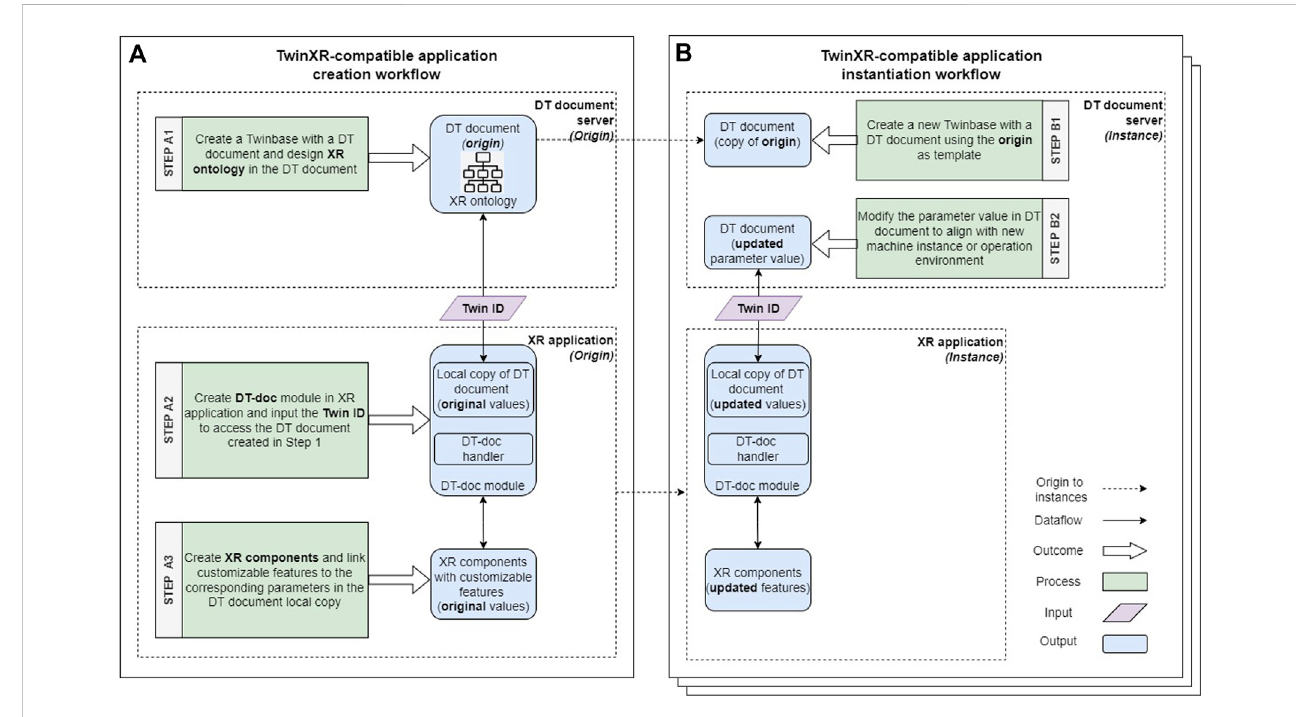
FIGURE 3 Work fl ows of creating a TwinXR-compatible application origin and adapting it to new instances . (A) TwinXR-compatible application creation work fl ow. (B) TwinXR-compatible application instantiation work fl